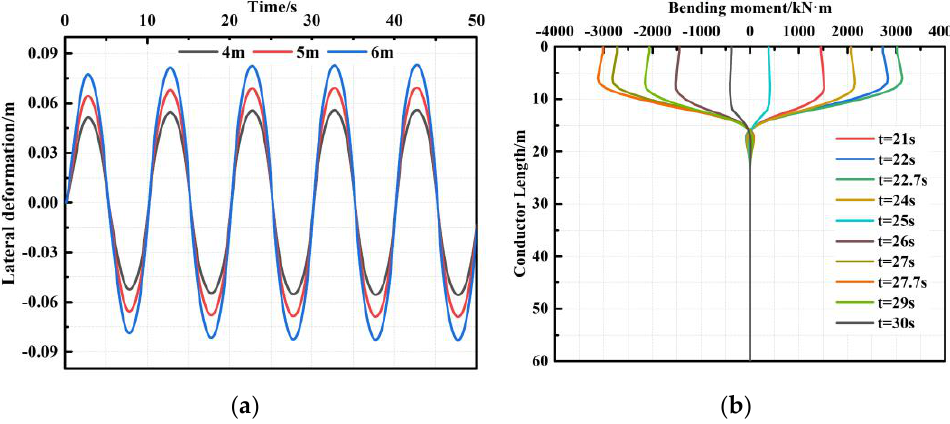
Figure 13. The influence of wellhead stick-up on the mechanical response of the conductor, where ( a ) is the variation of lateral moment at the top of the conductor with time and ( b ) is the variation of bending moment along the conductor axial direction when the wellhead stick-up is 6 m.